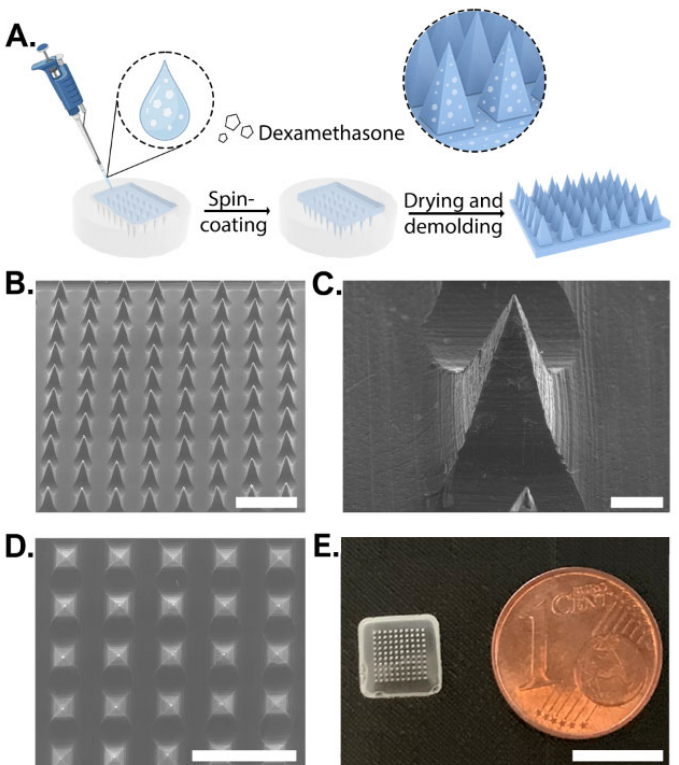
Figure 1. Schematic illustration of dexamethasone-loaded microneedle fabrication process and their morphology. ( A ) Manufacturing process using PDMS molding. ( B ) SEM image of microneedles containing dexamethasone. Scale bar: 1 mm. ( C ) SEM image of a well-structured MN. Scale bar: 100 µm. ( D ) Top view of SEM image. Scale bar: 1 mm. ( E ) Visual images of an MN. Scale bar: 8 mm.